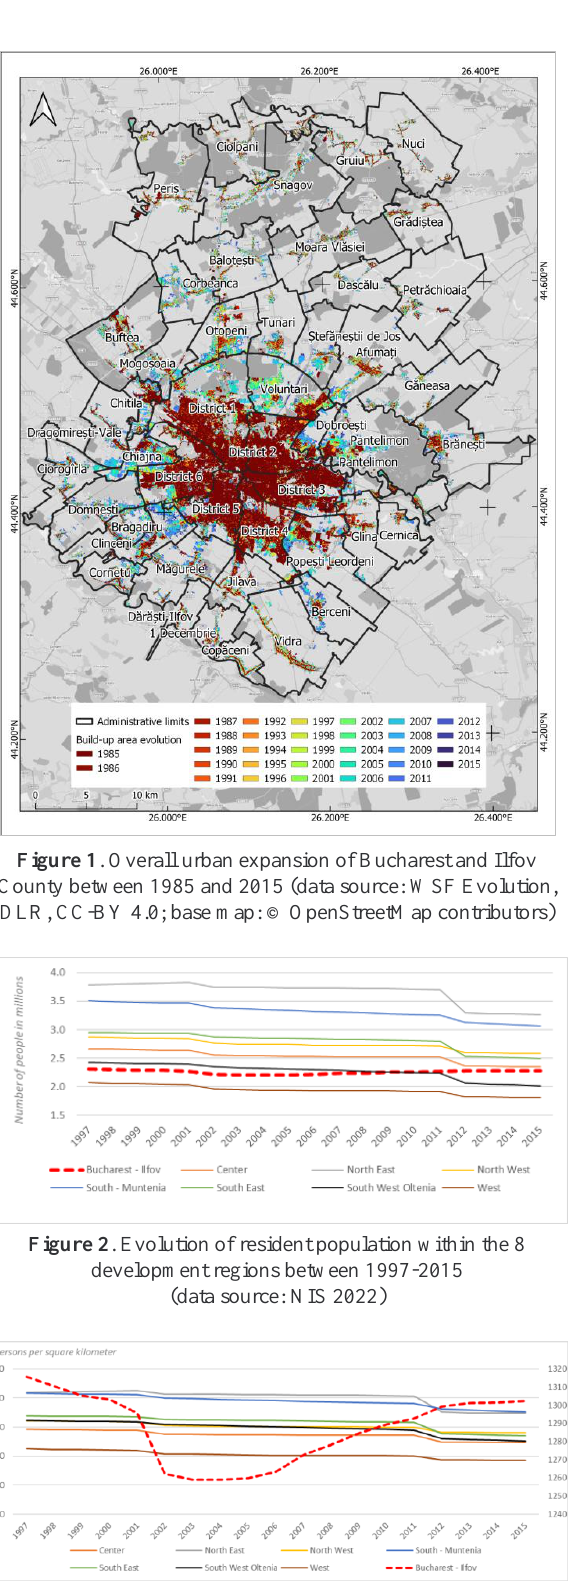
Figure 3 . Evolution of population density within the 8 development regions between 1997 and 2015. Values on the right of the graph correspond to Bucharest - Ilfov and the ones on the left concern the other development regions (data source: NIS